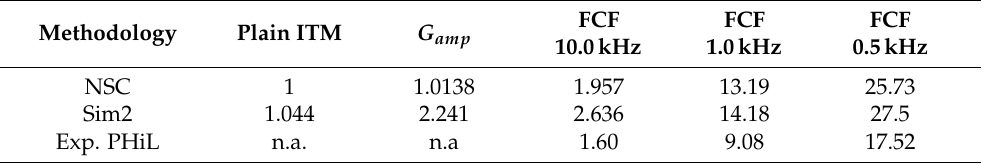
Table A2. Comparison of critical impedance ratio with theoretical stability criterion, simulative approach with offline- emt -model and practical PHiL simulation with the switching